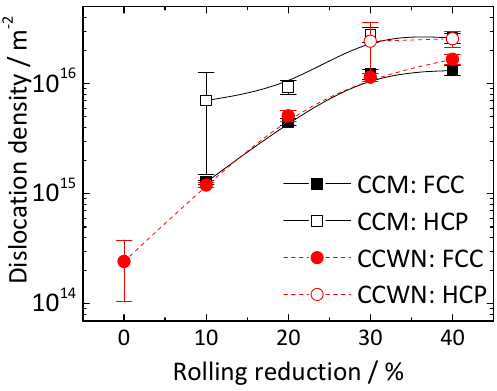
Figure 9. Variations in dislocation density of the FCC and HCP phases in the CCM and CCWN alloys.